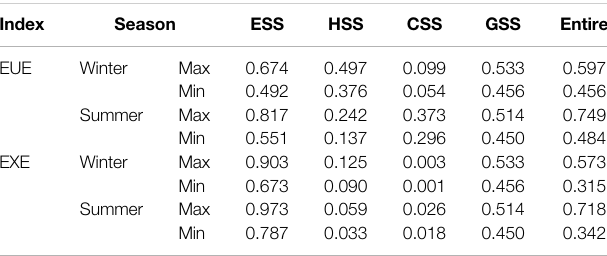
FIGURE 3 | The load data of IES in winter and summer. TABLE 3 | The energy ef fi ciency of IES.